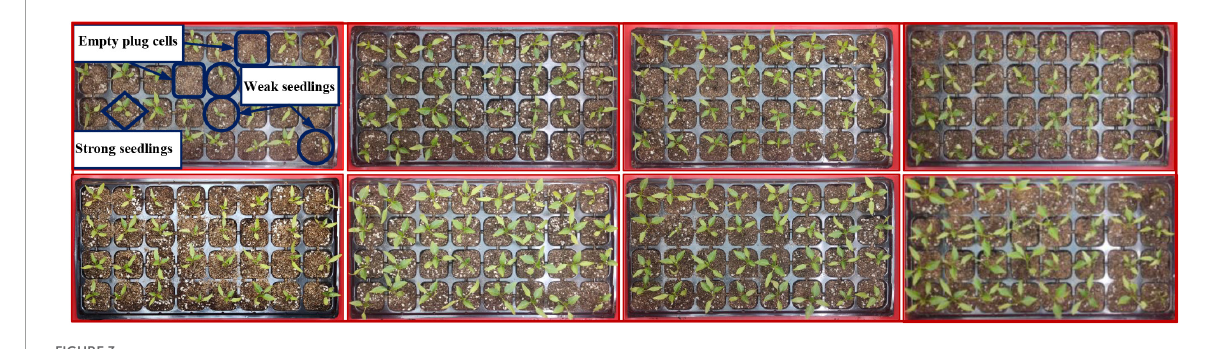
FIGURE3 Sample of pepper seedlings growing for 21